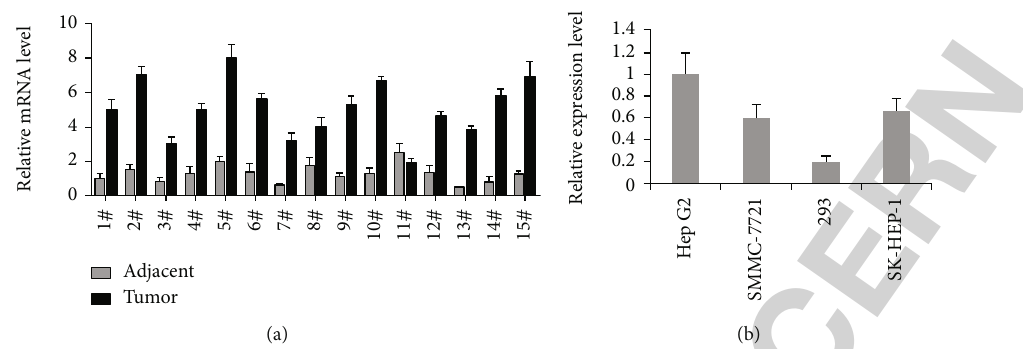
Figure 1: (a) 15 pairs of hepatocarcinoma specimens were detected by qRT-PCR, and the expression level of LOXL1-AS1 in tumor tissue was signi fi cantly higher than that in adjacent nontumor tissues. (b) LOXL1-AS1 expressions in three hepatocarcinoma and HEK-293 cell lines were tested by qRT-PCR analysis. The Hep-G2 cell had the highest expression in all four cell lines.